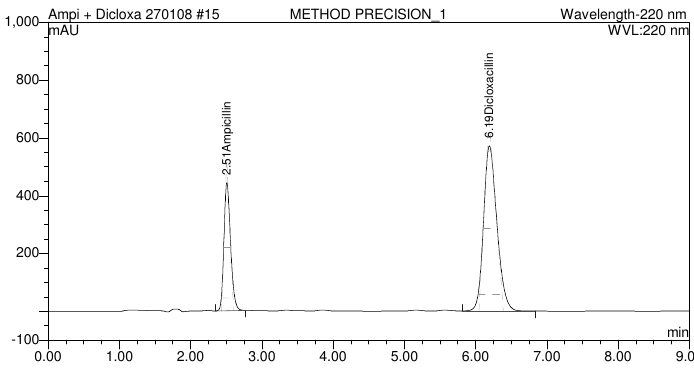
Figure 2. Chromatogram of method of precision of ampicilline trihydrate and